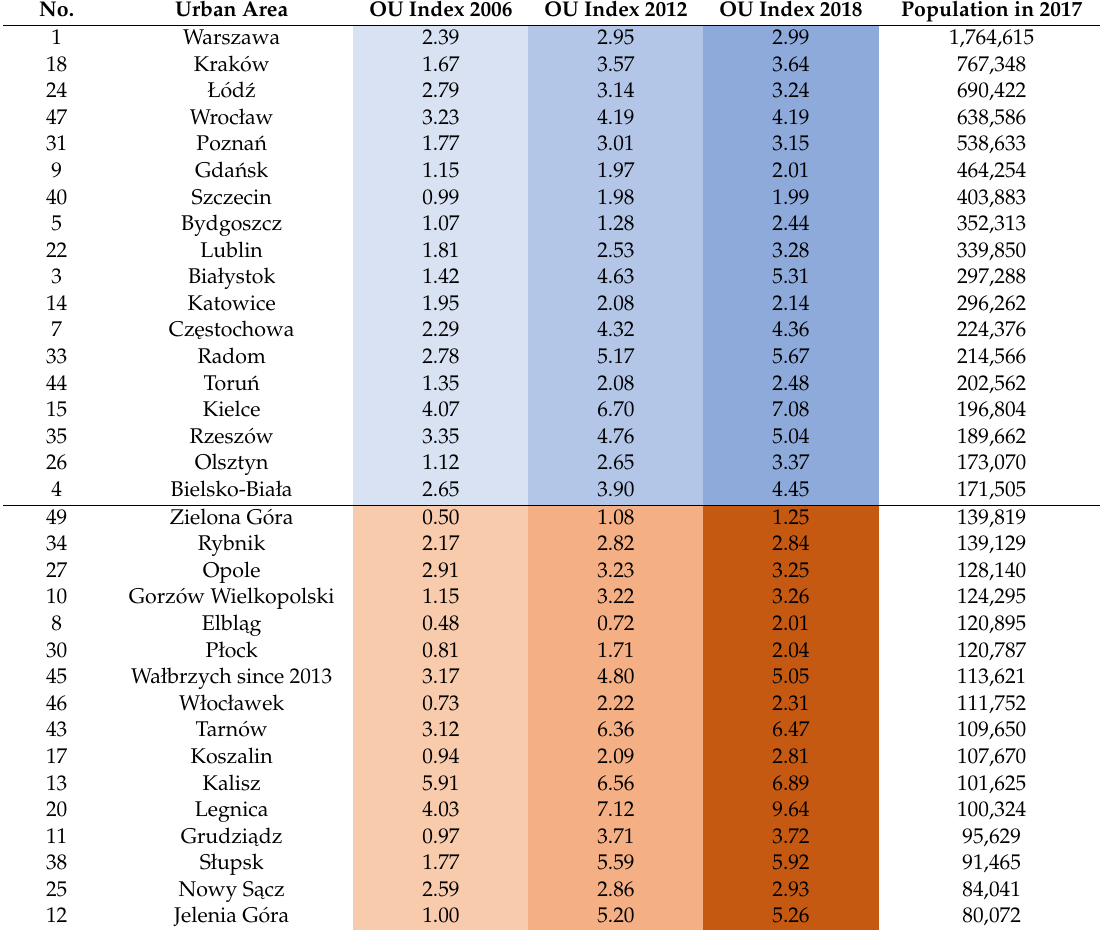
Table A3. Ranking of cities based on population with the corresponding values of the OU index. Demographic classes of cities have been marked in color. Big cities—blue, medium—orange, small—green.